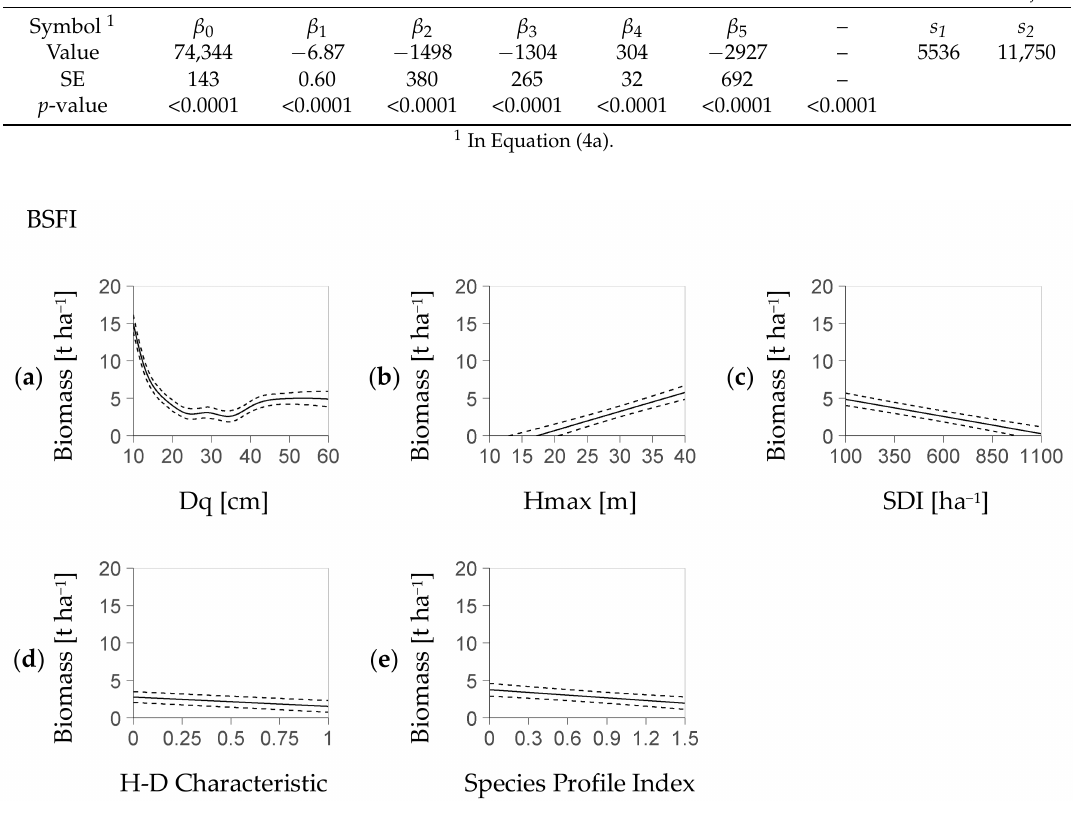
Figure 2. Profiles of regeneration biomass as predicted by the deterministic model part based on the BSFI (Bavarian State Forest Inventory, Equation (4b)). Each profile is presented over one predictor with, at the same time, the remainder predictors at their mean value (abbreviation H-D: Height-Diameter); profiles ordered by the relevance of the referring predictor based on the AIC criterion (( a – e ), see Section 2.4); dotted lines refer to the confidence interval; each predictor shown within its 95% interval; the stochastic part (Figure 3c,d) covers the residual distribution (profiles based on 5881 BSFI plots used for model